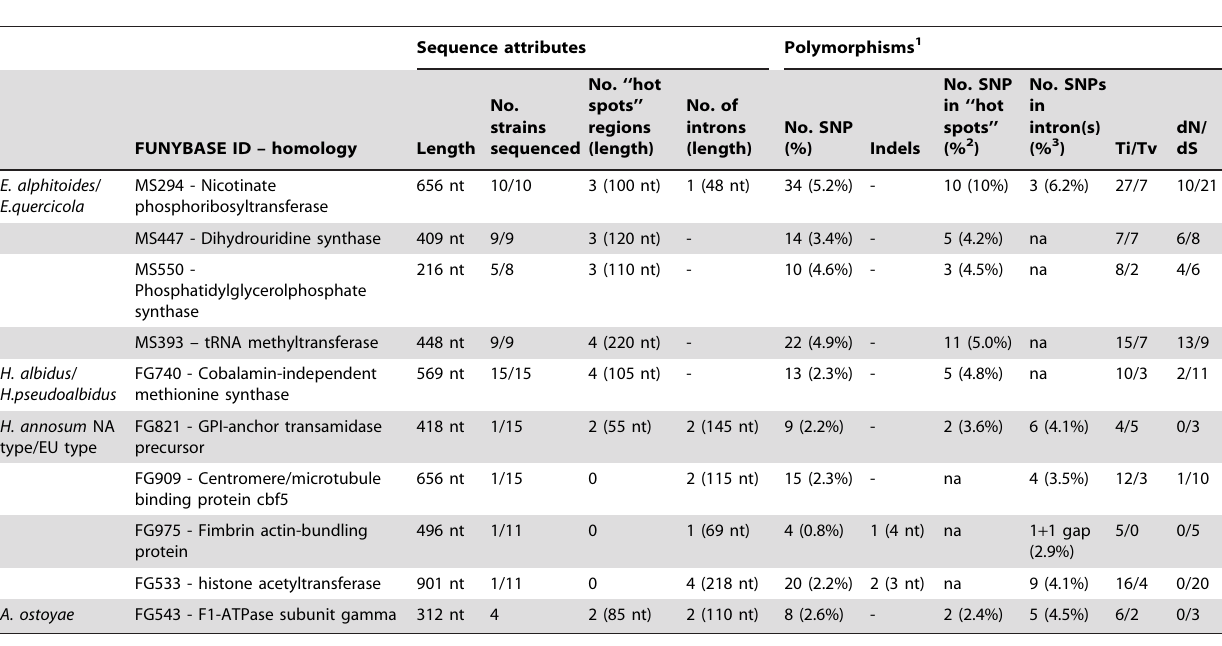
Table 3. Polymorphism results for the SCPCH candidates tested across the fungi